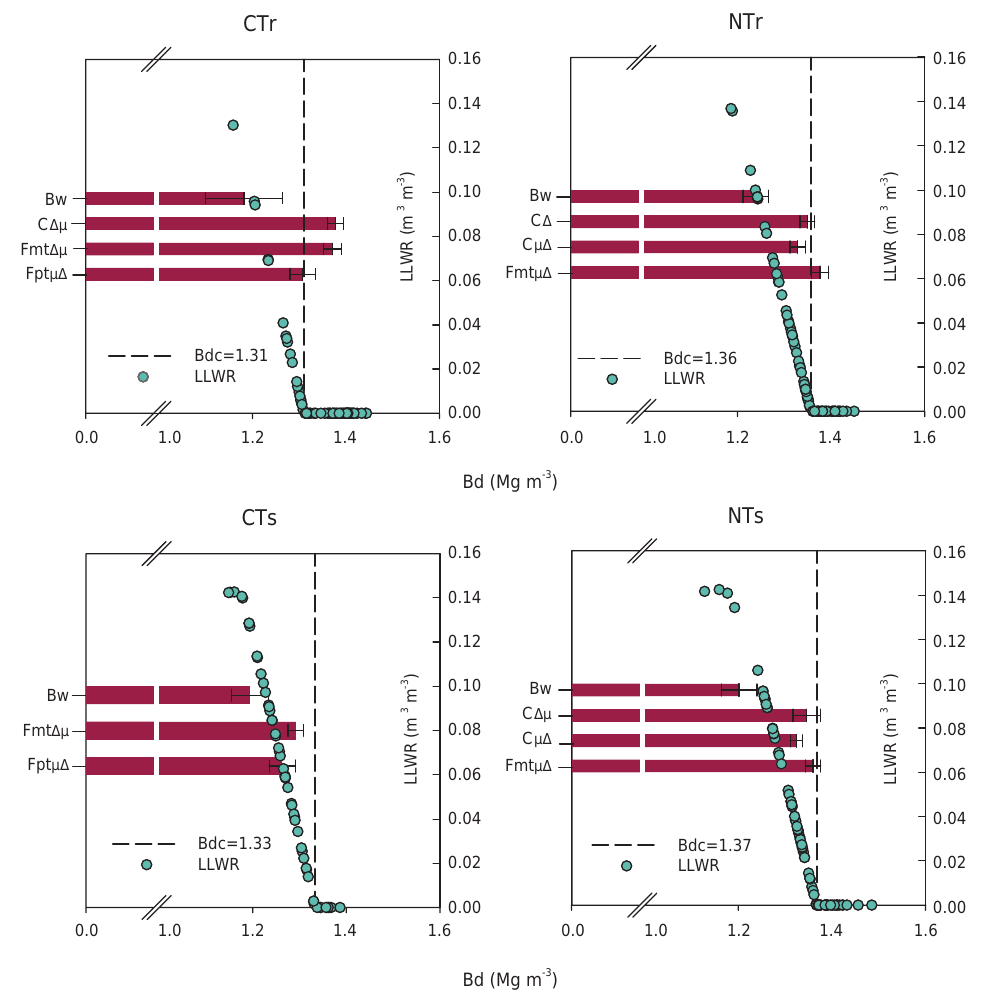
Figure 2. Bulk density (Bd) of the homogeneous morphological units and variation in the least limiting water range (LLWR) as a function of